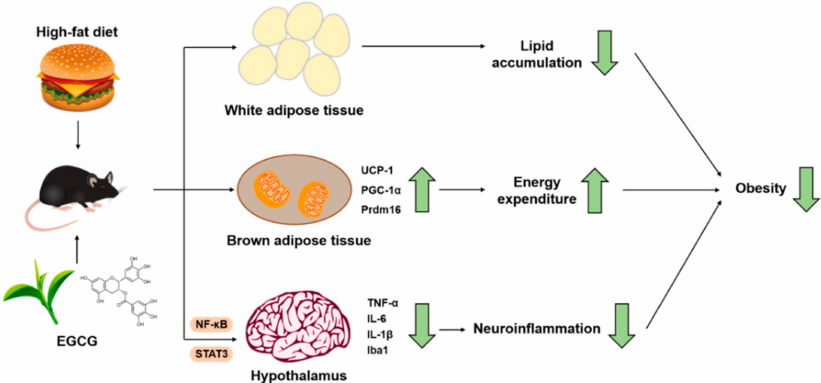
Figure 5. Schematic diagram showing the possible mechanisms of EGCG’s anti-obesity